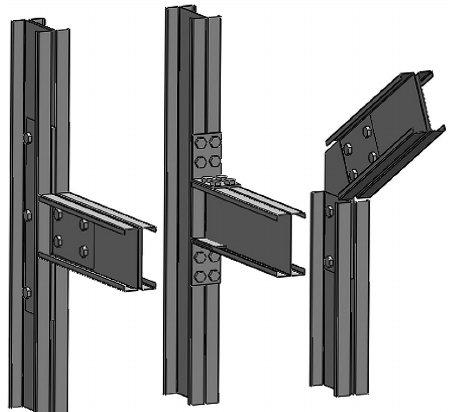
Fig. 2. Details of the arrangement for the apex joint (Lim, Nethercot 2003)